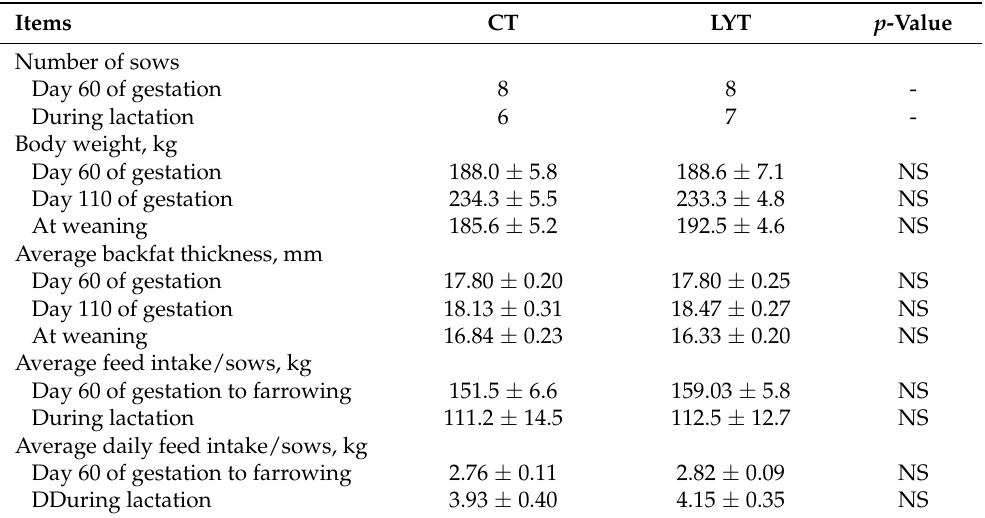
Table 3. The effects of dietary live yeast supplementation during middle–late gestation and lactation on body weight, backfat thickness, and feed intake of primiparous sows.